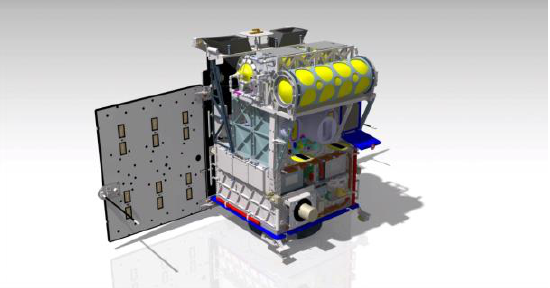
Figure 5. The BIROS satellite, planned to be piggy